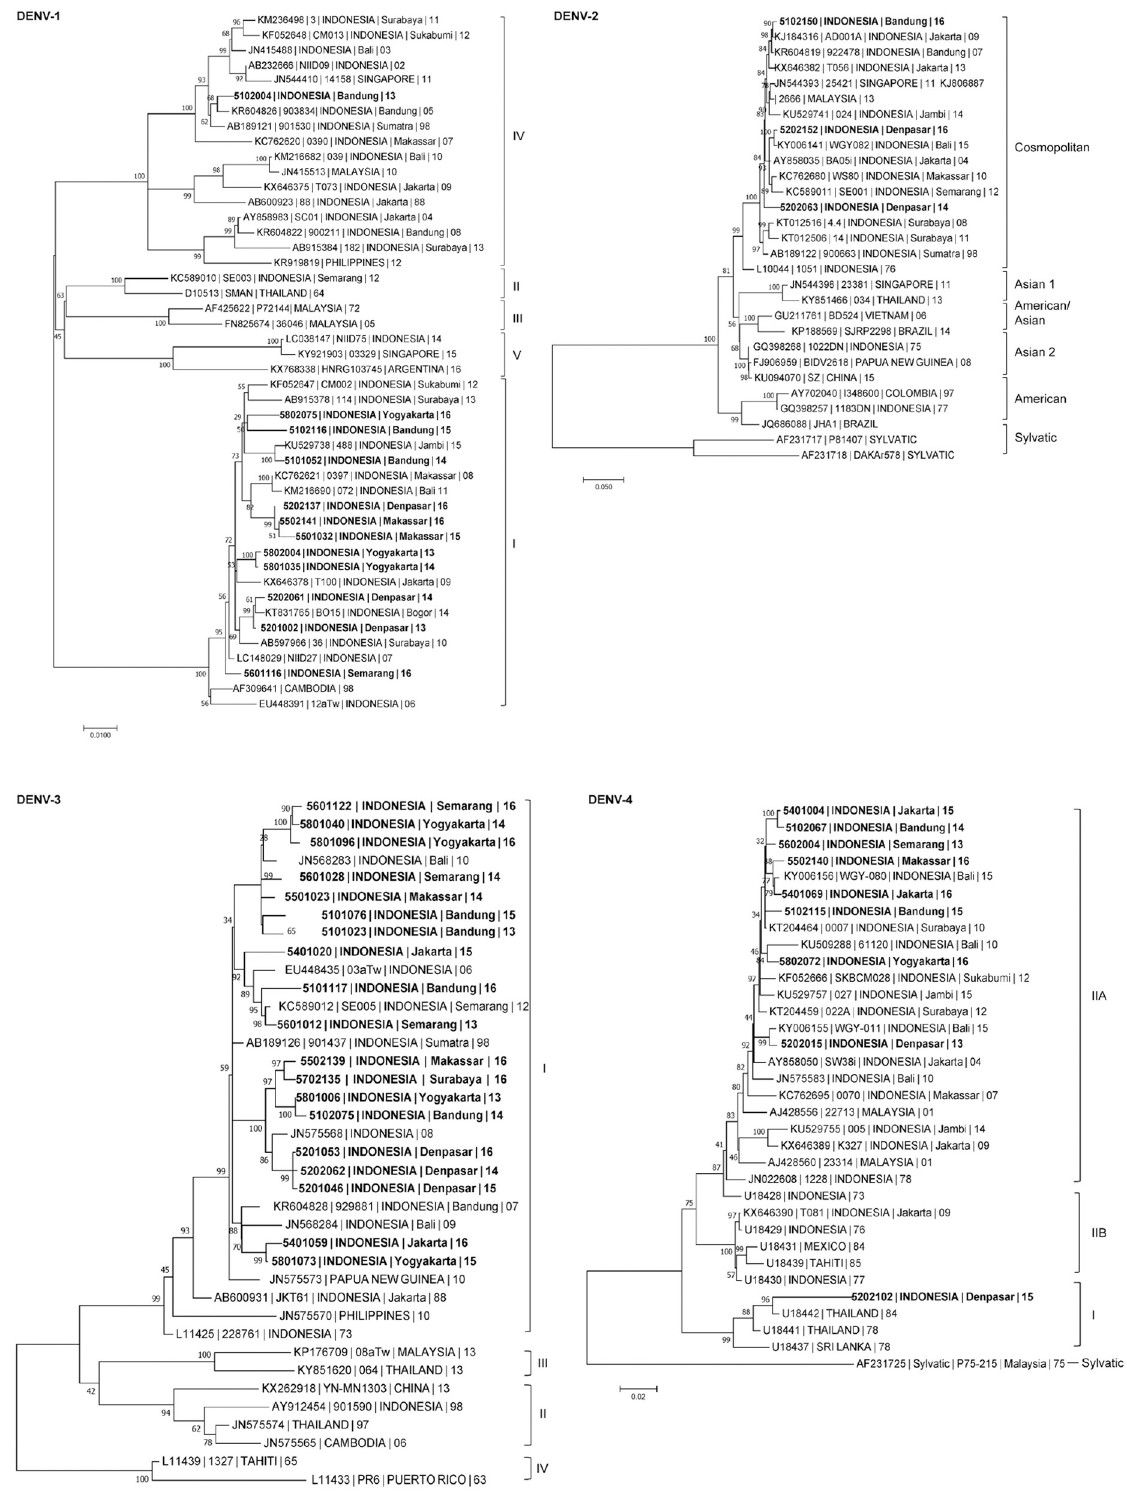
Fig 3. Phylogenetic trees showing the relationship of DENV identified in AFIRE study. The AFIRE DENV envelope (E) gene sequences are presented as: Subject Identification Number | Country | City | Year (in bold). The reference E gene sequences retrieved from GenBank